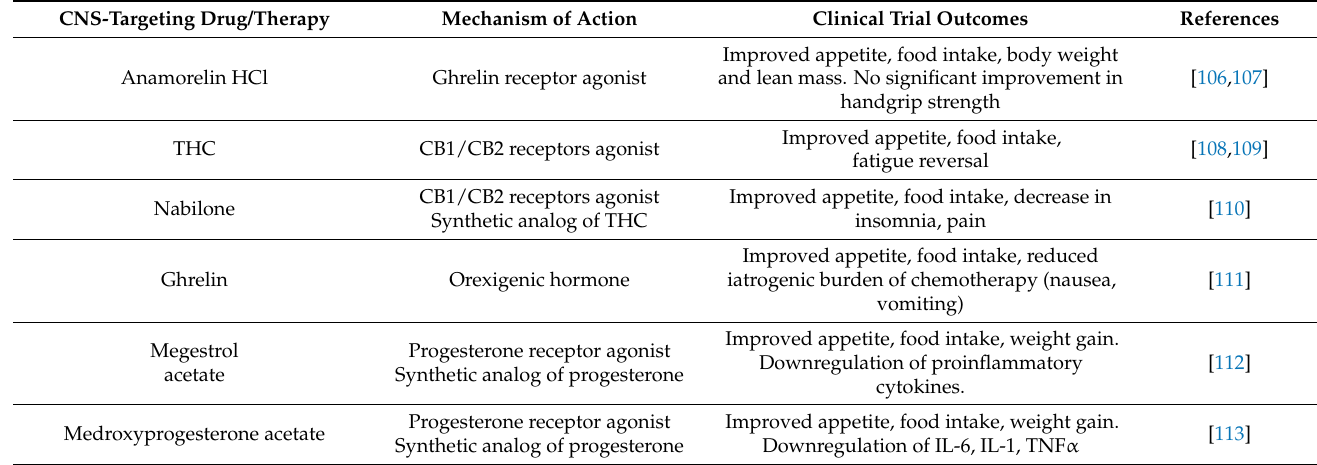
Table 2. Summary of cachexia clinical trials targeting, in part, the